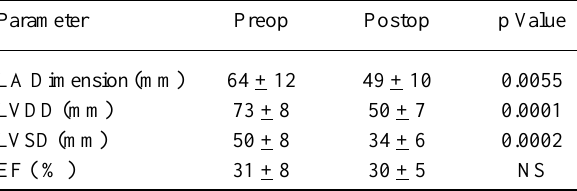
Table 2. Echocardiographic parameters comparison between preop and postop